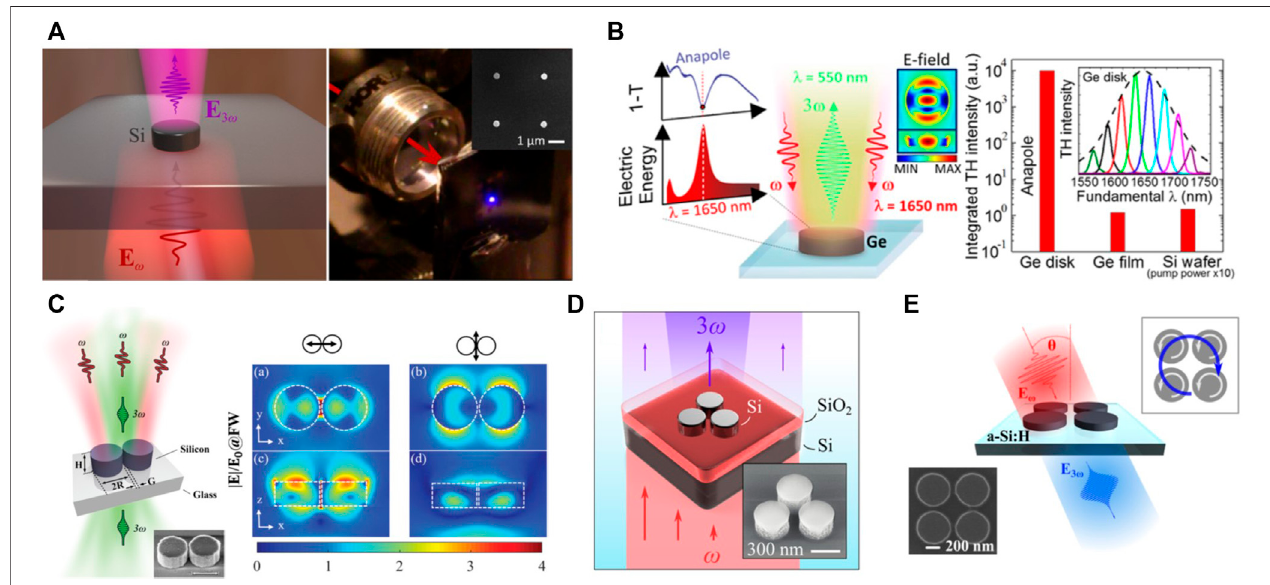
FIGURE 2 | Nonlinear THG processes from dielectric nanostructures with different geometries. (A) Illustration of THG from individual Si nanodisks and the photographic image of the sample (Shcherbakov et al., 2014). (B) Illustration of THG for a single Ge nanodisk and the THG performances at anapole resonance compared with unstructured Ge fi lm and the silicon wafer. The insets are the electric fi eld enhancement at anapole resonance and the fundamental wavelength dependence of the TH spectrum (Grinblat et al., 2016a). (C) Illustration of Si nanodimers for THG near electric and magnetic resonances and its electric fi eld distributions at a fundamental wavelength for two polarizations (Wang et al., 2017). (D) Illustration of THG in Si nanodisk trimers and its SEM image (Shcherbakov et al., 2015). (E) Illustration of THG in Si quadrumers. The insets are the SEM image of the sample and the physical origin of magnetic Fano resonance in the quadrumer (Shorokhov et al.,